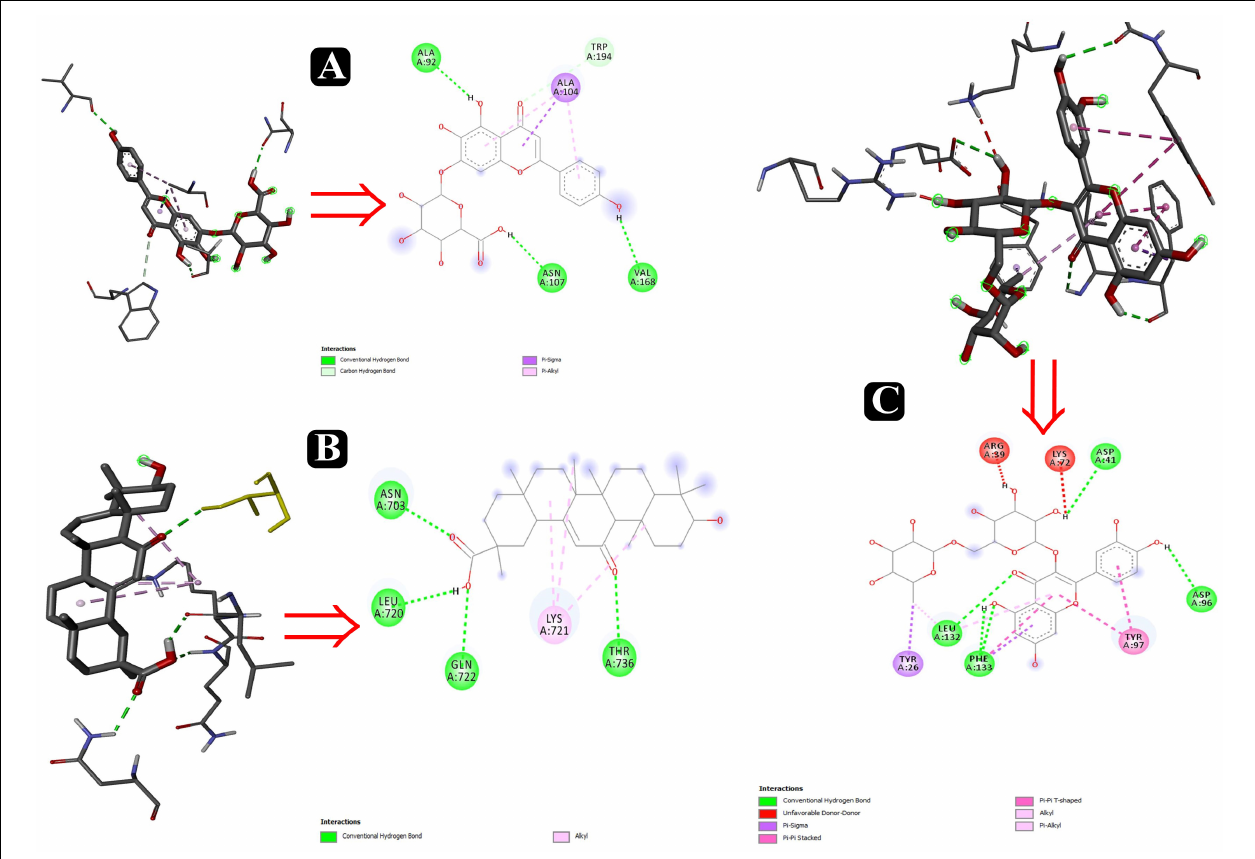
FIGURE 10 | Interactions of adhesin proteins with phytochemicals. (A) 1T2P from S. aureus with higher binding affinity antibiofilm agent scutellarin. Interaction of active site amino acid residue VAL 168, ASN107, TRP194, ALA104, and ALA92 from 1T2P with scutellarin; (B) 3ML3 from S. flexneri with higher binding affinity antibiofilm agent 18- β -glycyrrhetinic acid. Interaction of active site amino acid residue ASN703, LEU720, GLN722, and THR736 from 3ML3 with 18- β -glycyrrhetinic acid; and (C) 3SY7 from P. aeruginosa with higher binding affinity antibiofilm agent rutin. Interaction of active site amino acid residue TYR26, LEU132,